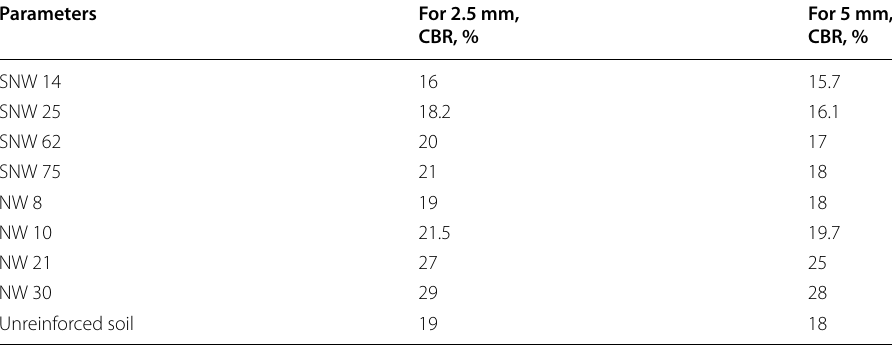
Table 4 Comparison of various geotextile’s with unreinforced soil